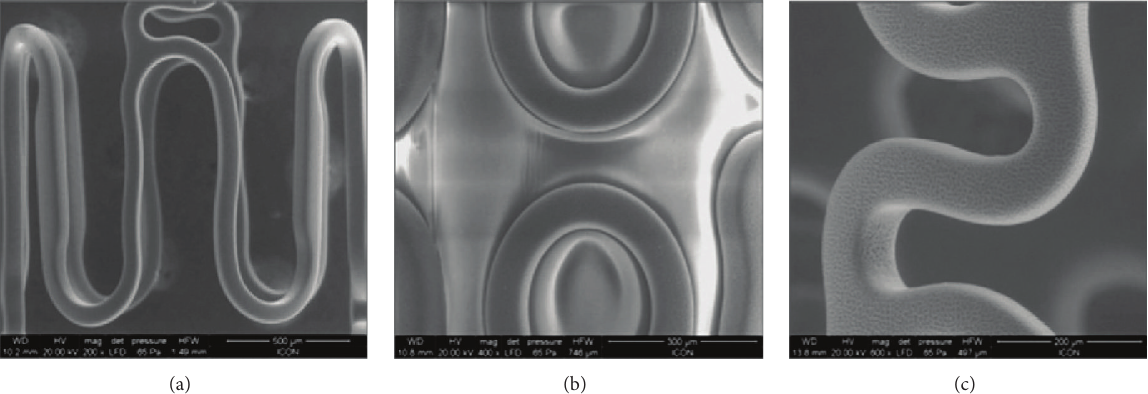
Figure 3: Scanning electron microscopy (SEM) images of a (a) normal, (b) crimped, and (c) expanded Supraflex sirolimus-eluting stent.